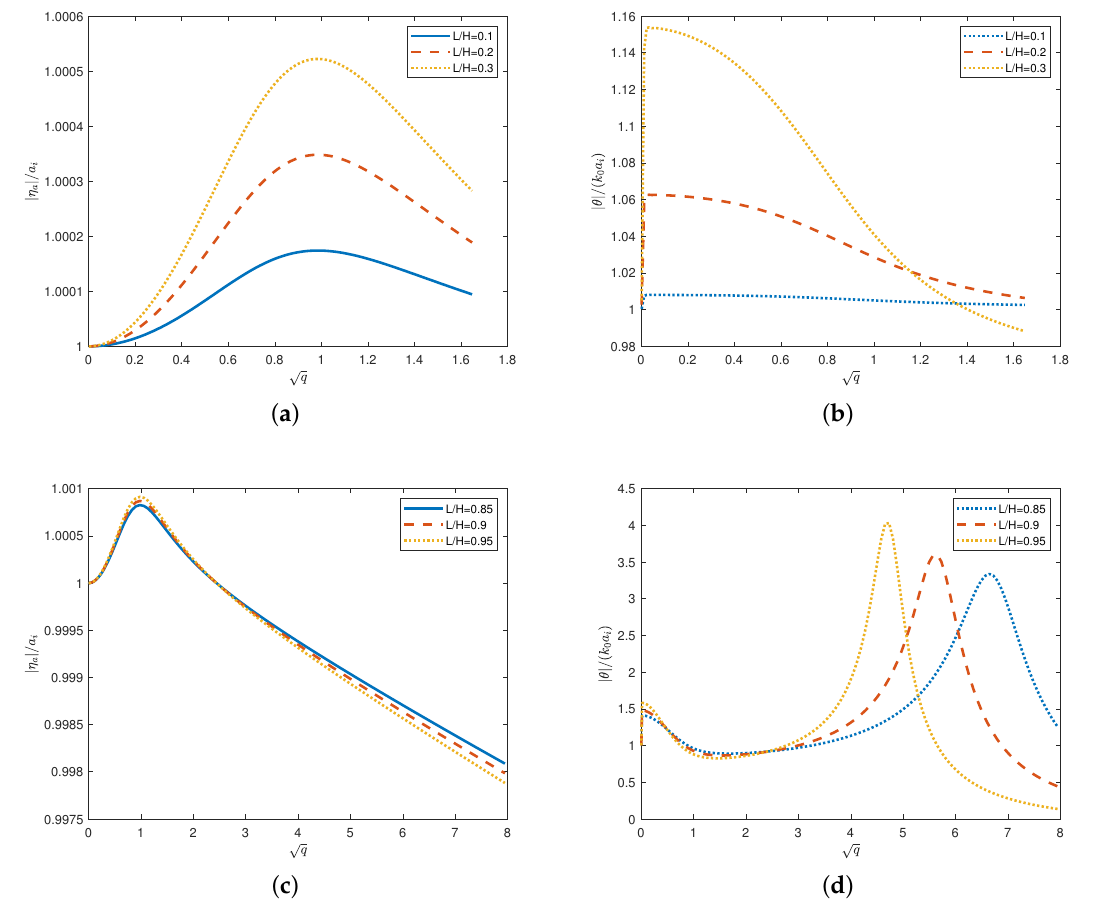
Figure 3. The dimensionless amplitudes of the heave ( a , c ), and pitch ( b , d ), motions of the rigid plate as functions of the dimensionless frequency ˜ L = L / H